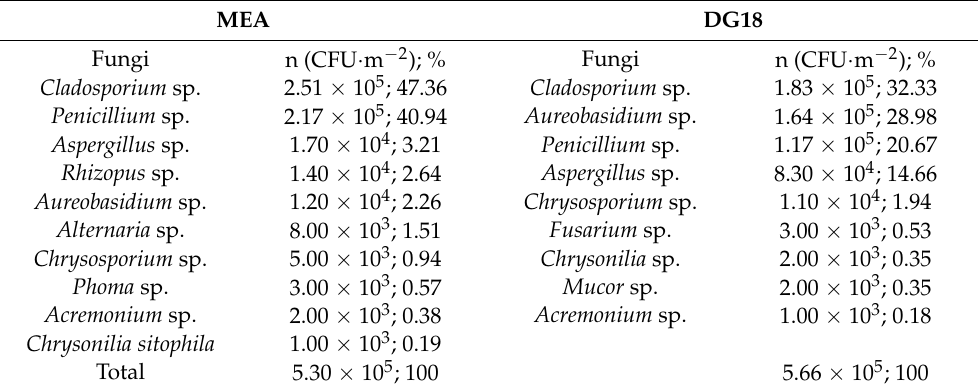
Table 2. Fungal species distribution in surface swabs after inoculation onto MEA and DG18 media.